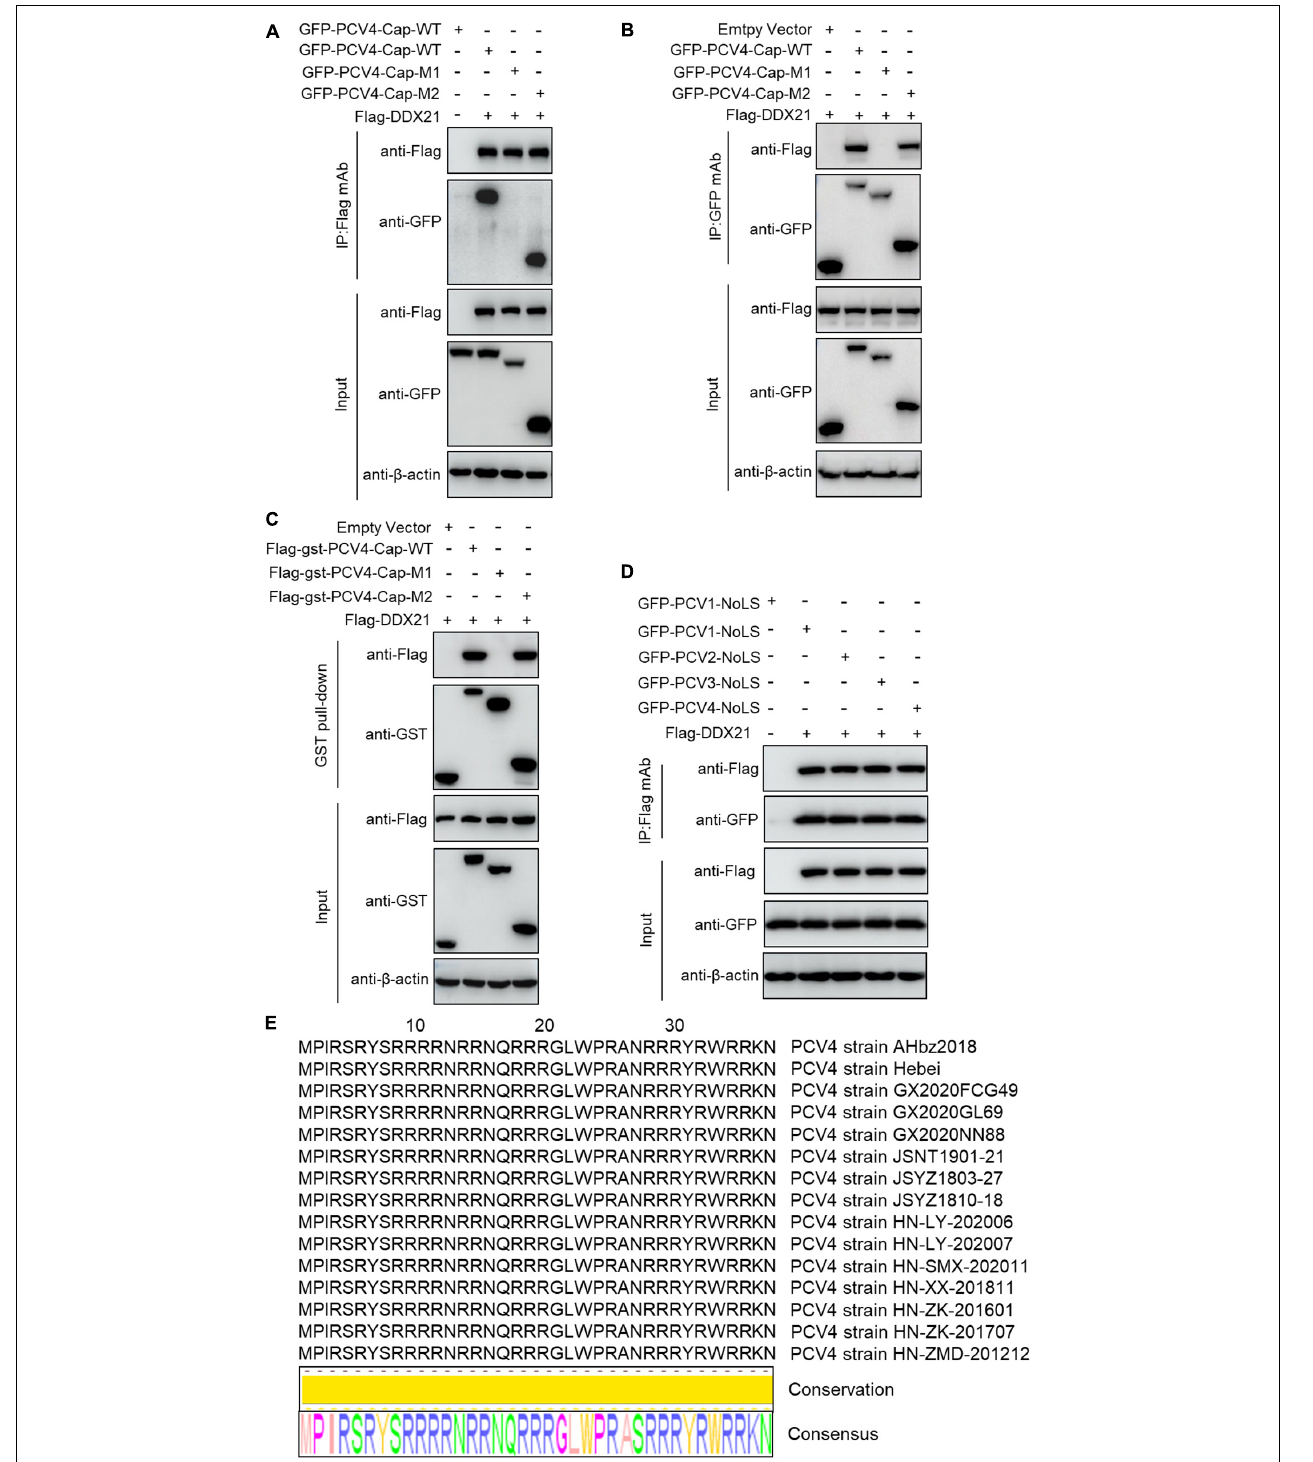
FIGURE 3 | The N-terminal residues 1–37 of PCV4 Cap are essential for binding to DDX21. (A–C) HEK293T cells were co-transfected with plasmids containing full-length PCV4 Cap or truncated mutants fused with a GFP-, or Flag-GST tag, along with Flag-DDX21 plasmid for 48 h; the cell lysate extracts were immunoprecipitated with Flag beads (A) or anti-GFP purified IgG (B) , or pulled-down with glutathione S-transferase (GST) beads (C) and then detected by western blotting using the indicated antibodies. (D) The nucleolar localization signals (NoLSs) within capsid protein of PCV1, 2, 3, 4 were responsible for the binding to DDX21. HEK293T cells were cotransfected with plasmids encoding NoLSs of PCV1, 2, 3, 4, along with Flag-DDX21; cell lysates were subjected to immunoprecipitation and immunoblotting using the indicated antibodies. (E) Amino acid sequences alignment of the NoLSs from different PCV4 strains.